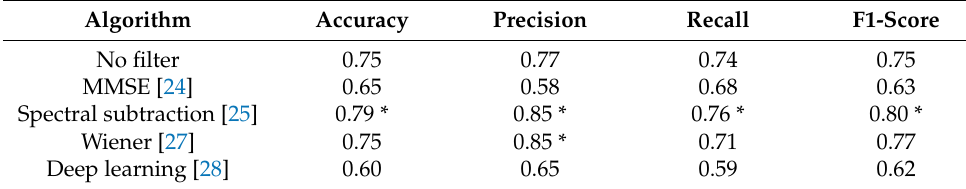
Table 12. Office Noise SNR − 5. * is the best result for each particular